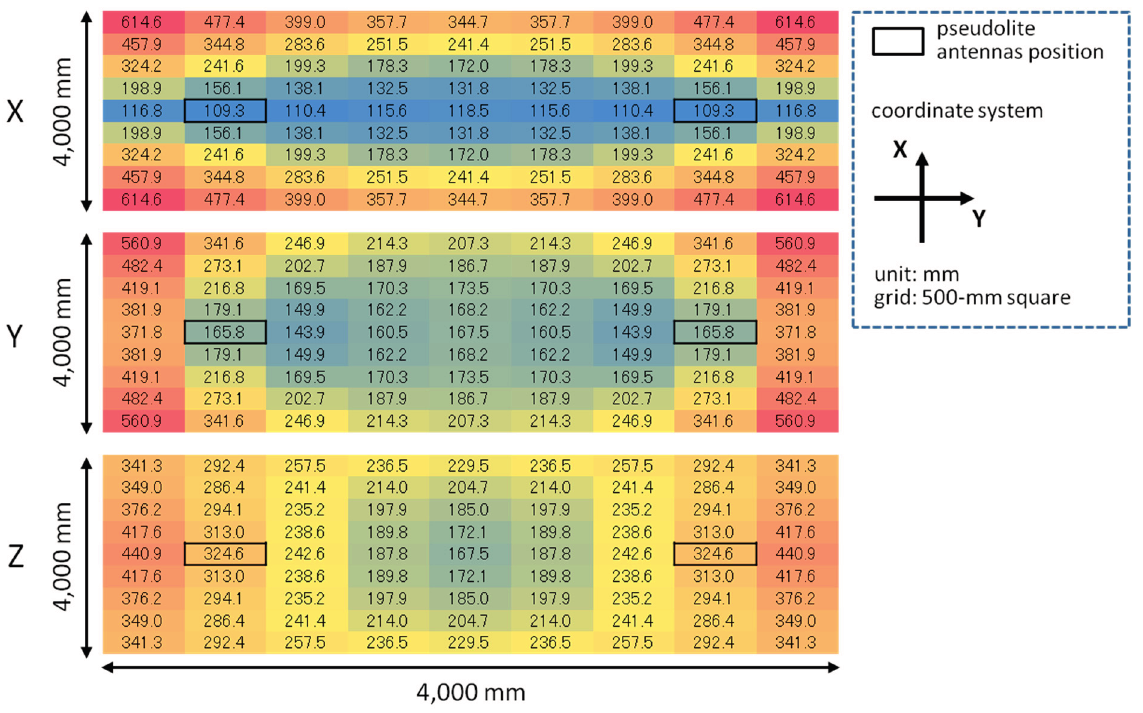
Figure 11. Error simulation results for each of x -, y -, and z -coordinates with single array.